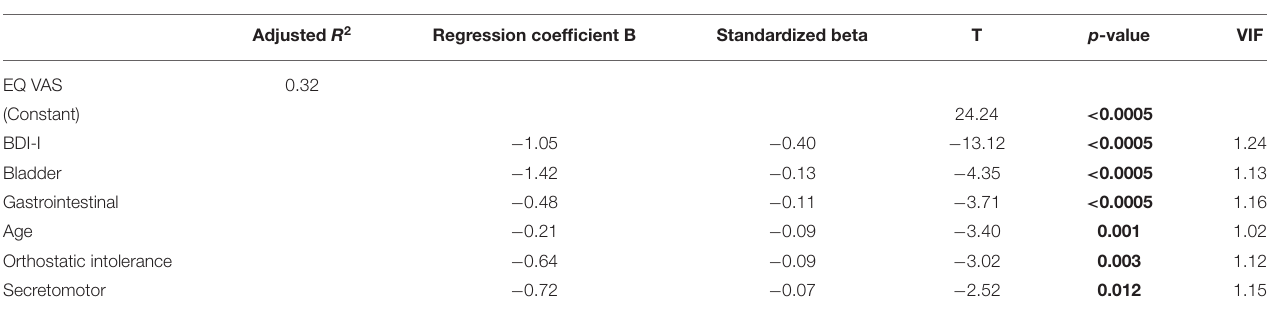
TABLE 3 | Autonomic symptoms and Health-Related Quality of Life: model with